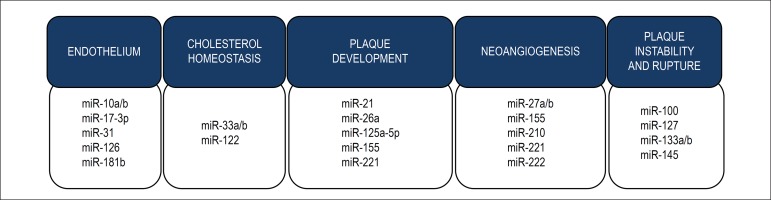
Atherosclerosis and miRNAs. Dysregulation of the expression of
several miRNAs has been found in different stages of atherosclerosis
formation. Some of the miRNAs involved in endothelial dysfunction
and inflammation, cholesterol homeostasis, plaque development,
neoangiogenesis and plaque instability and rupture are here
illustrated.